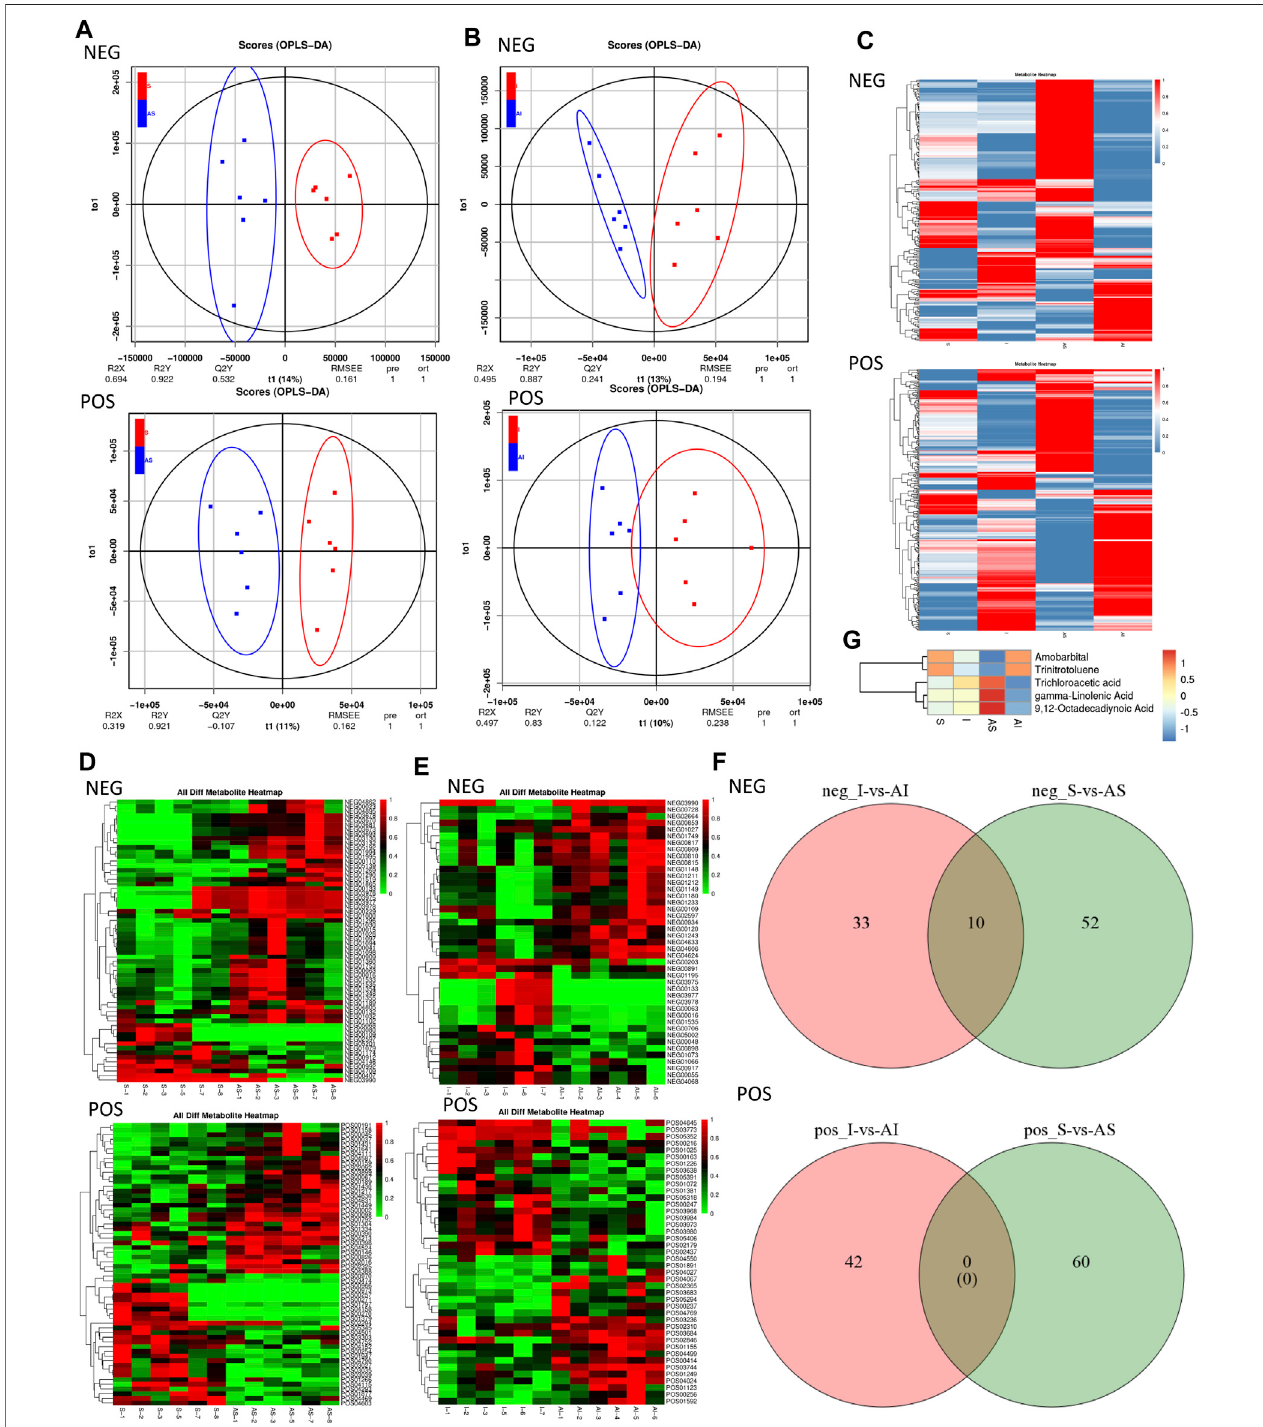
FIGURE 5 | Screening and identi fi cation of the differential metabolites in the different groups. The score plot of the metabolic differences between group S and AS (A) , and between group I and AI (B) by Orthogonal Projections to Latent Structures Discriminant Analysis (OPLS-DA) in both positive and negative ion modes. The heat maps of different metabolites in each sample from the four different groups in both positive and negative ion mode (C) . The ionic strengths of both the positive and negativemodesofthedifferentmetabolites between groupSand AS (D) ,and betweengroup IandAI (E) byvariableimportancein projection(VIP) generatedafter OPLS-DA. The subsequent Venn diagram inthe negativeion mode (F) . The mean relative abundance of fi ve known differential metabolites in thedifferent groups (G) . S: sham; AS: ARB + sham; I: injury; AI: ARB + injury.